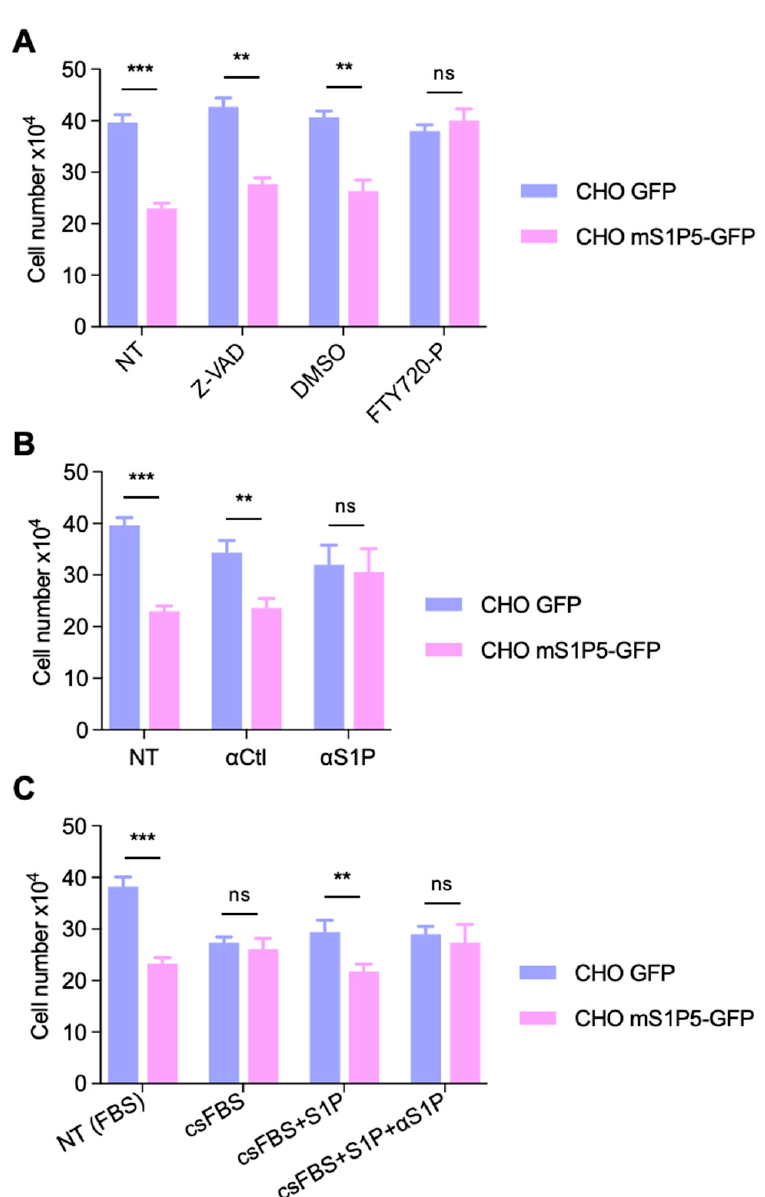
Figure 6. S1P5-induced growth inhibition is ligand-dependent. ( A ), CHO cells expressing mS1P5- GFP or GFP alone were plated at 20,000 cells/well in 12 well-plates. After 16 h, cells were left untreated (NT) or treated with Z-VAD (10 µ M), vehicle (DMSO), or FTY720-P (1 µ M), and the cell number was counted 48 h post treatment. Graphs show means ± SEM from three